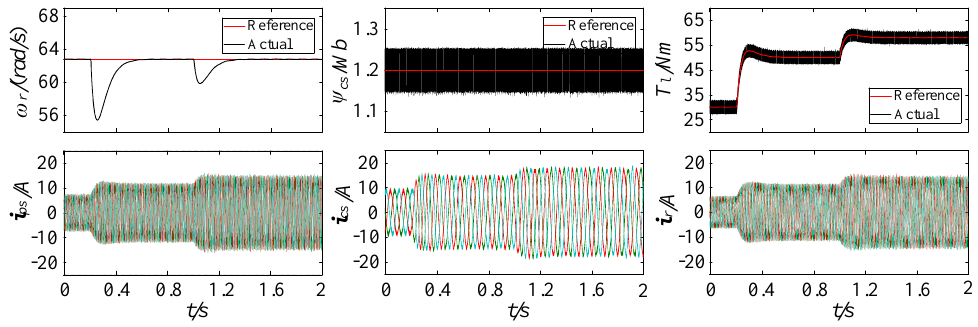
Figure 16. Simulation waveforms of SVDTC at limit torque.